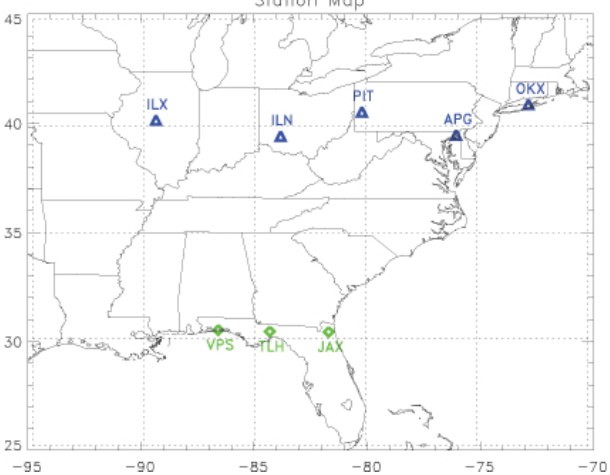
Fig. 3. Launch sites for the radiosondes used in the present study. Blue triangles denote the northern stations located at around 40 ◦ N, green diamonds denote the southern stations near 30 ◦ N.